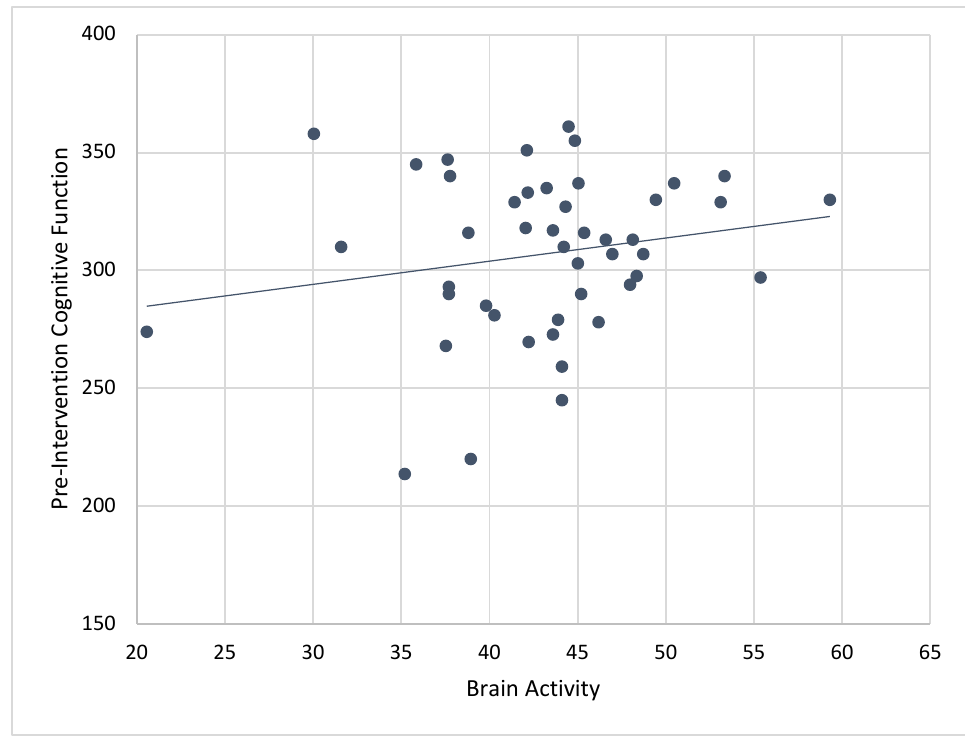
Figure 6. Correlation between pre-intervention composite cognitive scores and brain activity for the treatment (ABC) group. Composite cognitive function scores at baseline predicted mean levels of brain activity during cognitive training (r = 0.35, p < 0.01), and also when controlling for age (r p = 0.41, p < 0.01).